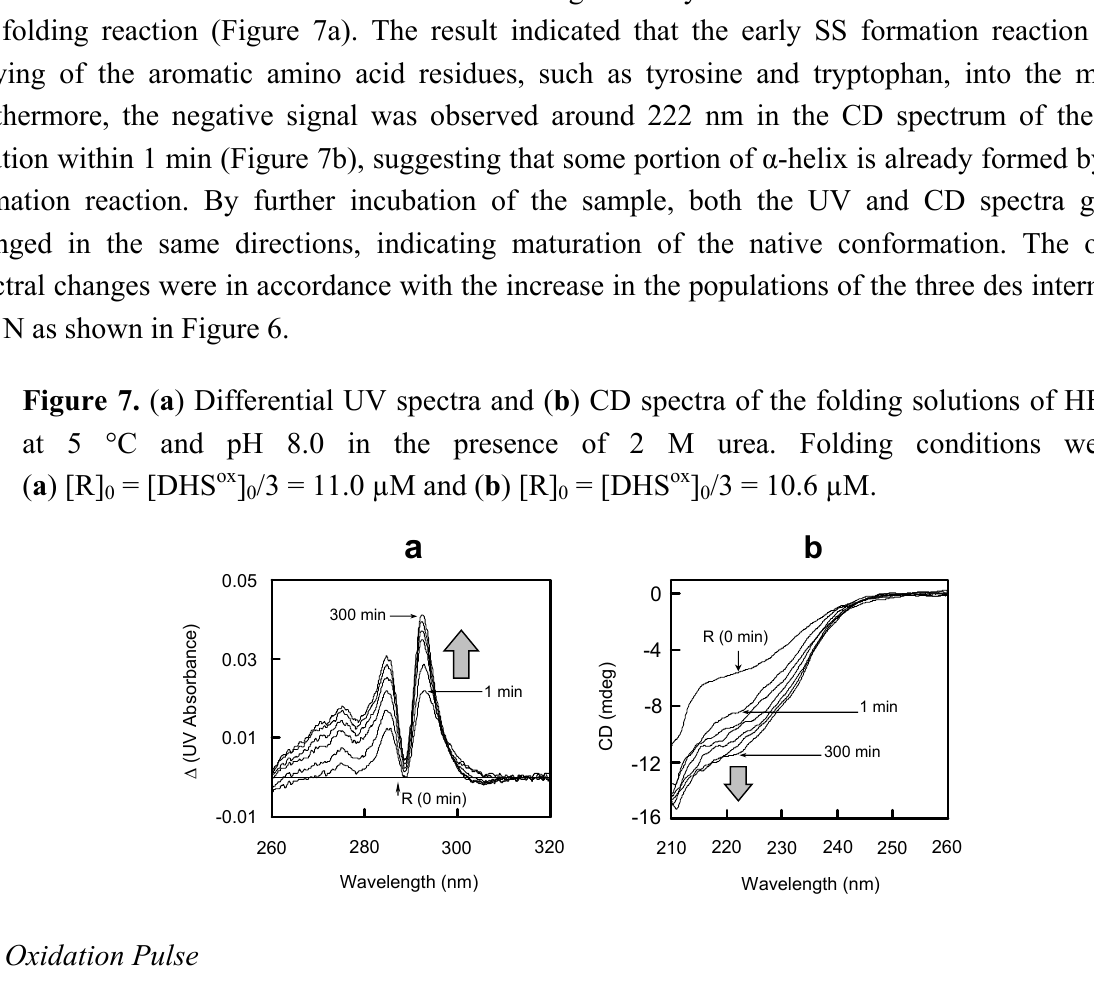
= [DHS ox ] /3 = 10.6 0 0